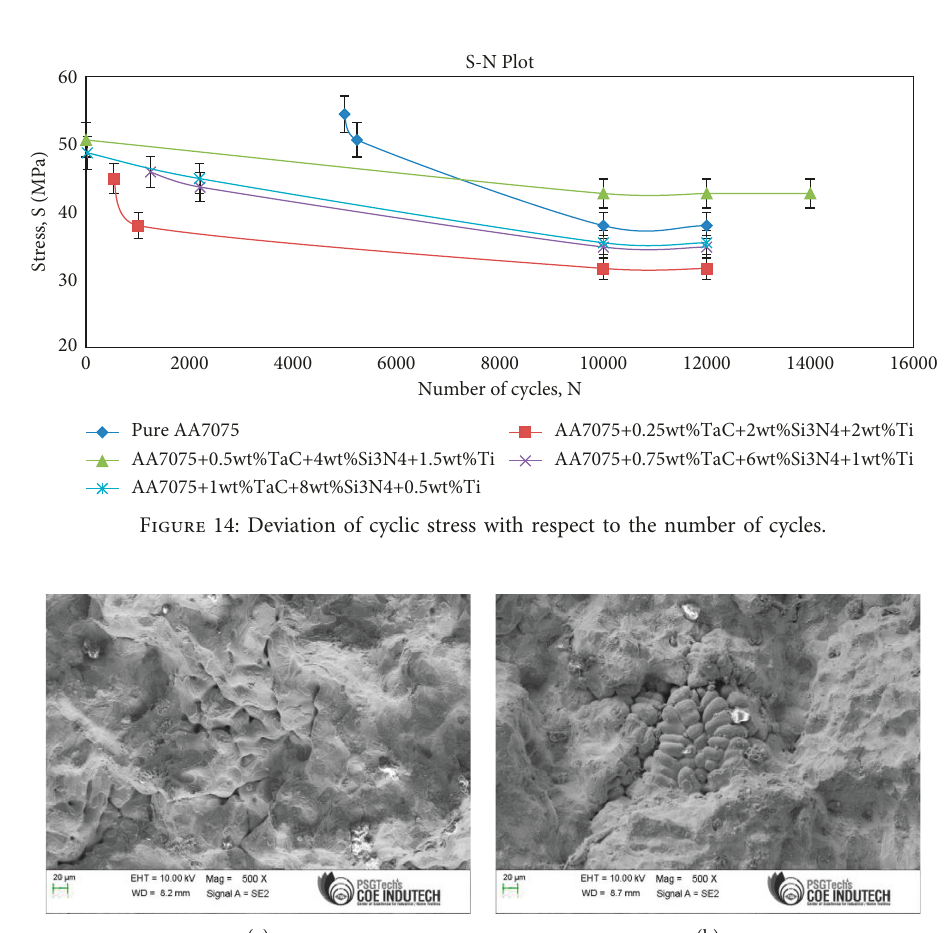
° C and (b) 120 ° C. 3 N 4 /0.5wt%Ti tensile sample: (a) 30